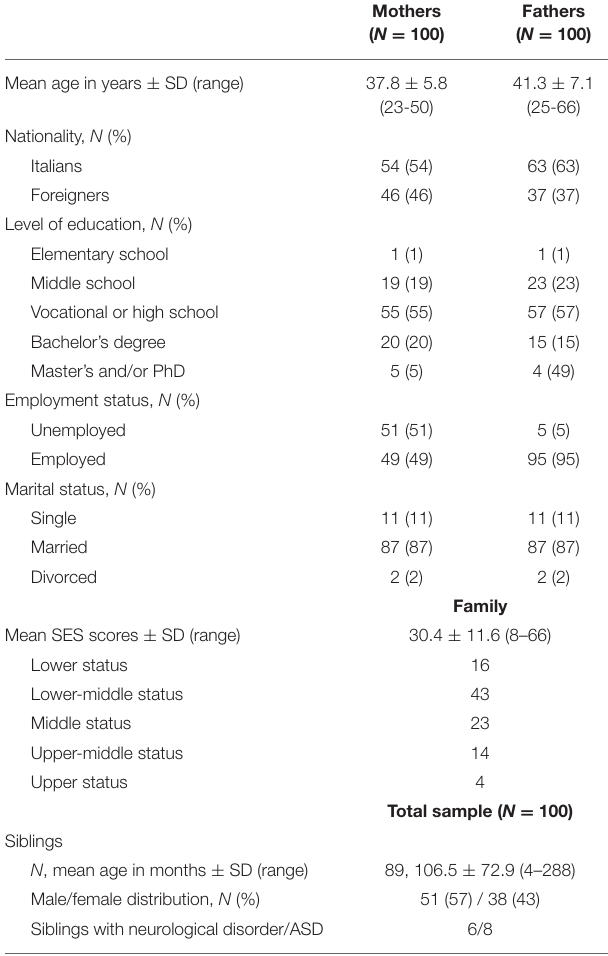
TABLE 1 | Sociodemographic data and family